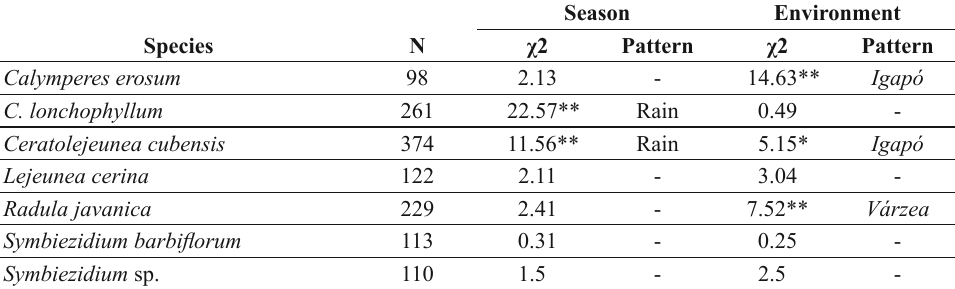
Result of the chi-square test for the fertility of the species in both forests ( várzea and igapó ) and in both periods (dry and rainy). *Signi fi cant at p <0.05 level. **Signi fi cant at p <0.001 level. Degree of freedom = 1. N = Number of samples. χ 2 = test result